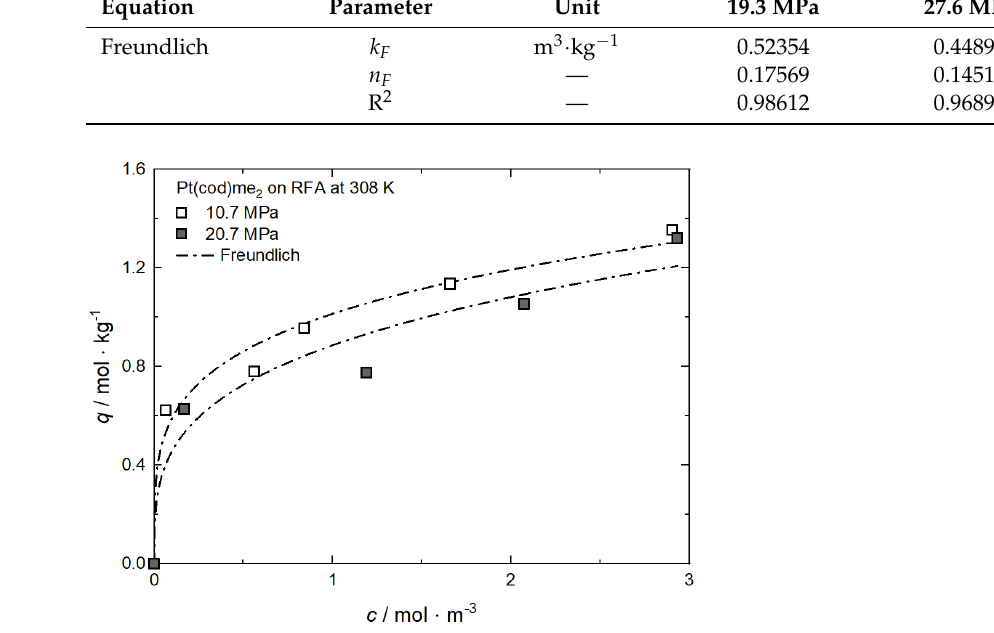
Table A3. Adsorption isotherm parameters for Ru(cod)(tmhd) 2 from scCO 2 solution on CA22 at 353 K and different pressures [63].